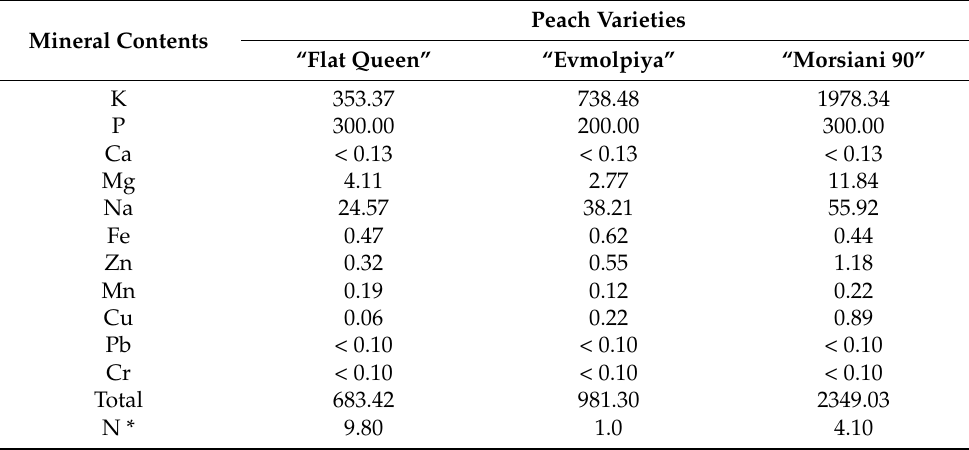
Table 4. Mineral content of different varieties of late season peach ( Prunus persica L.) varieties, mg/kg fw